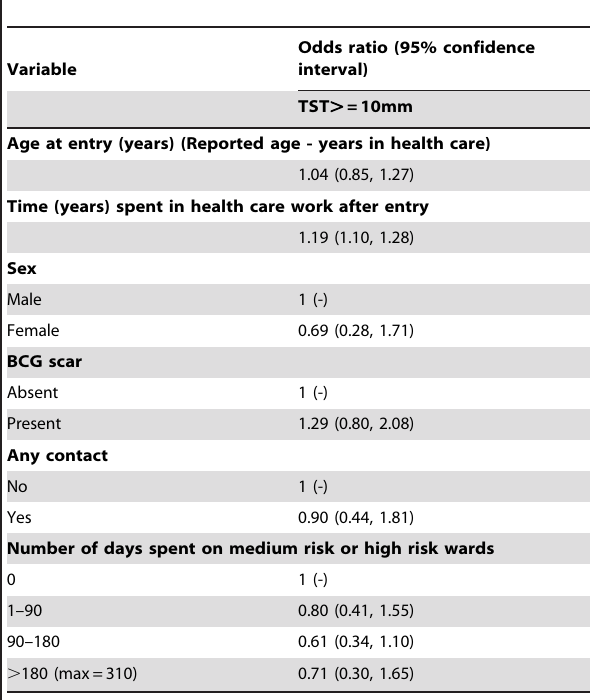
Table 6. Factors associated with TST results: multivariate logistic regression model.*